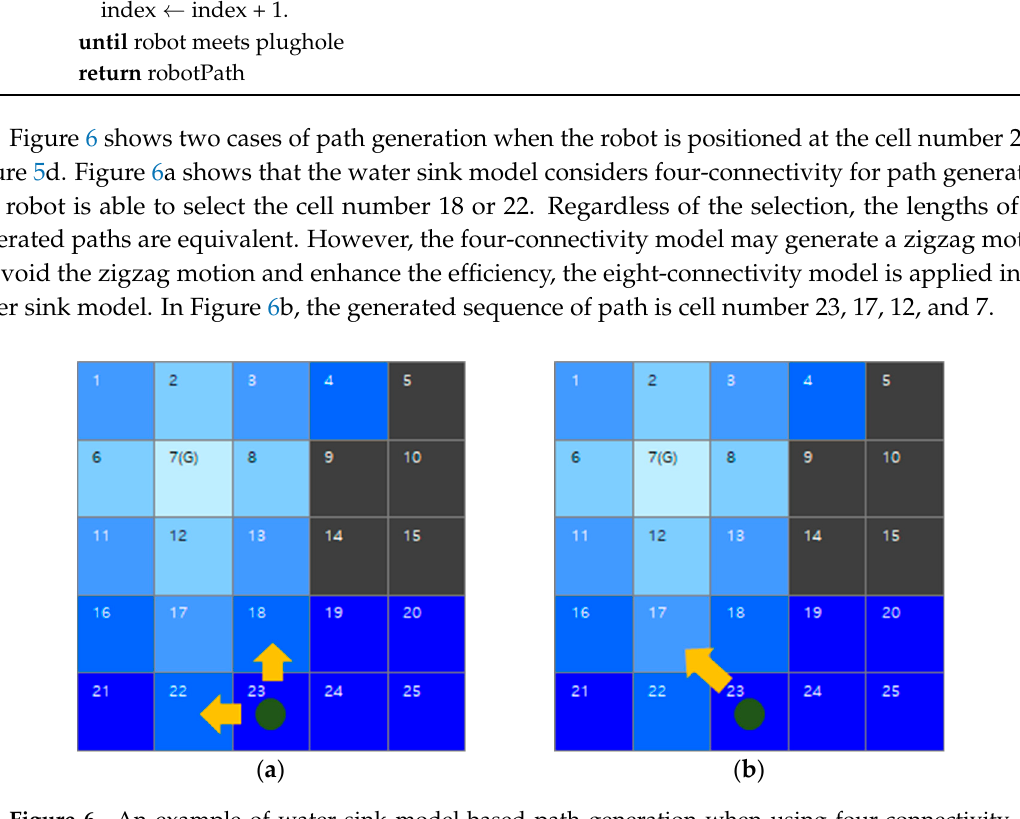
Figure 6. An example of water sink model-based path generation when using four-connectivity and eight-connectivity: ( a ) the case of four-connectivity for robot movement; ( b ) the case of eight-connectivity for robot movement.